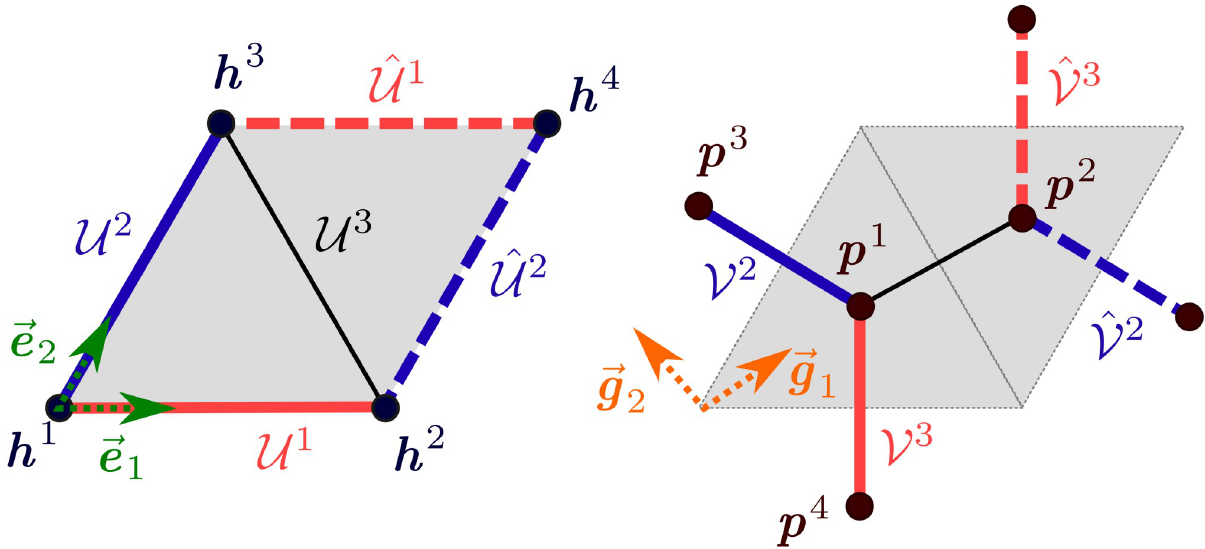
and Y , see Eqs (5) and (6). p h